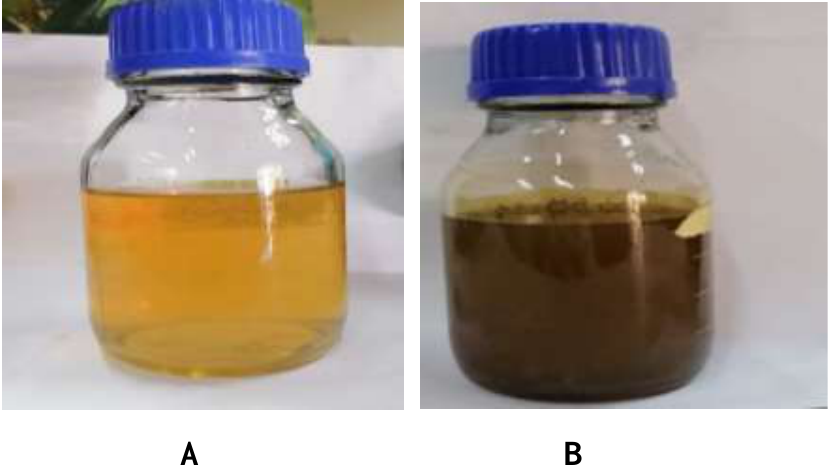
Figure 1: Extracellular mycosynthesis of AgNPs using the supernatant of C. albicans . (A) refers to supernatant of C. albicans and AgNo solution before mycosynthesis, (B) refers to the mycosynthesis 3 of AgNPs by C. albicans after 24 h at 37°C in dark